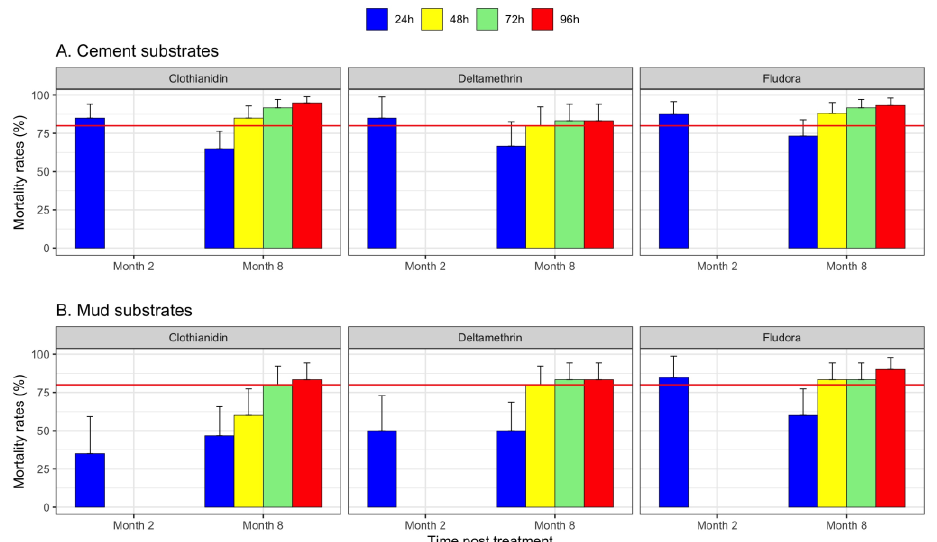
Figure 2. Mortality rates recorded after exposure of the An. arabiensis resistant strain on cement ( A ) and mud ( B ) supports in the experimental station, 2 and 8 months after the Fludora ® Fusion, deltamethrin, and clothianidin at 24 h, 48 h, 72 h, and 96 h. The horizontal red line indicates the 80% WHO threshold limit of efficacy. The bars indicate the upper limits of the 95% confidence intervals associated with the mortality rates.